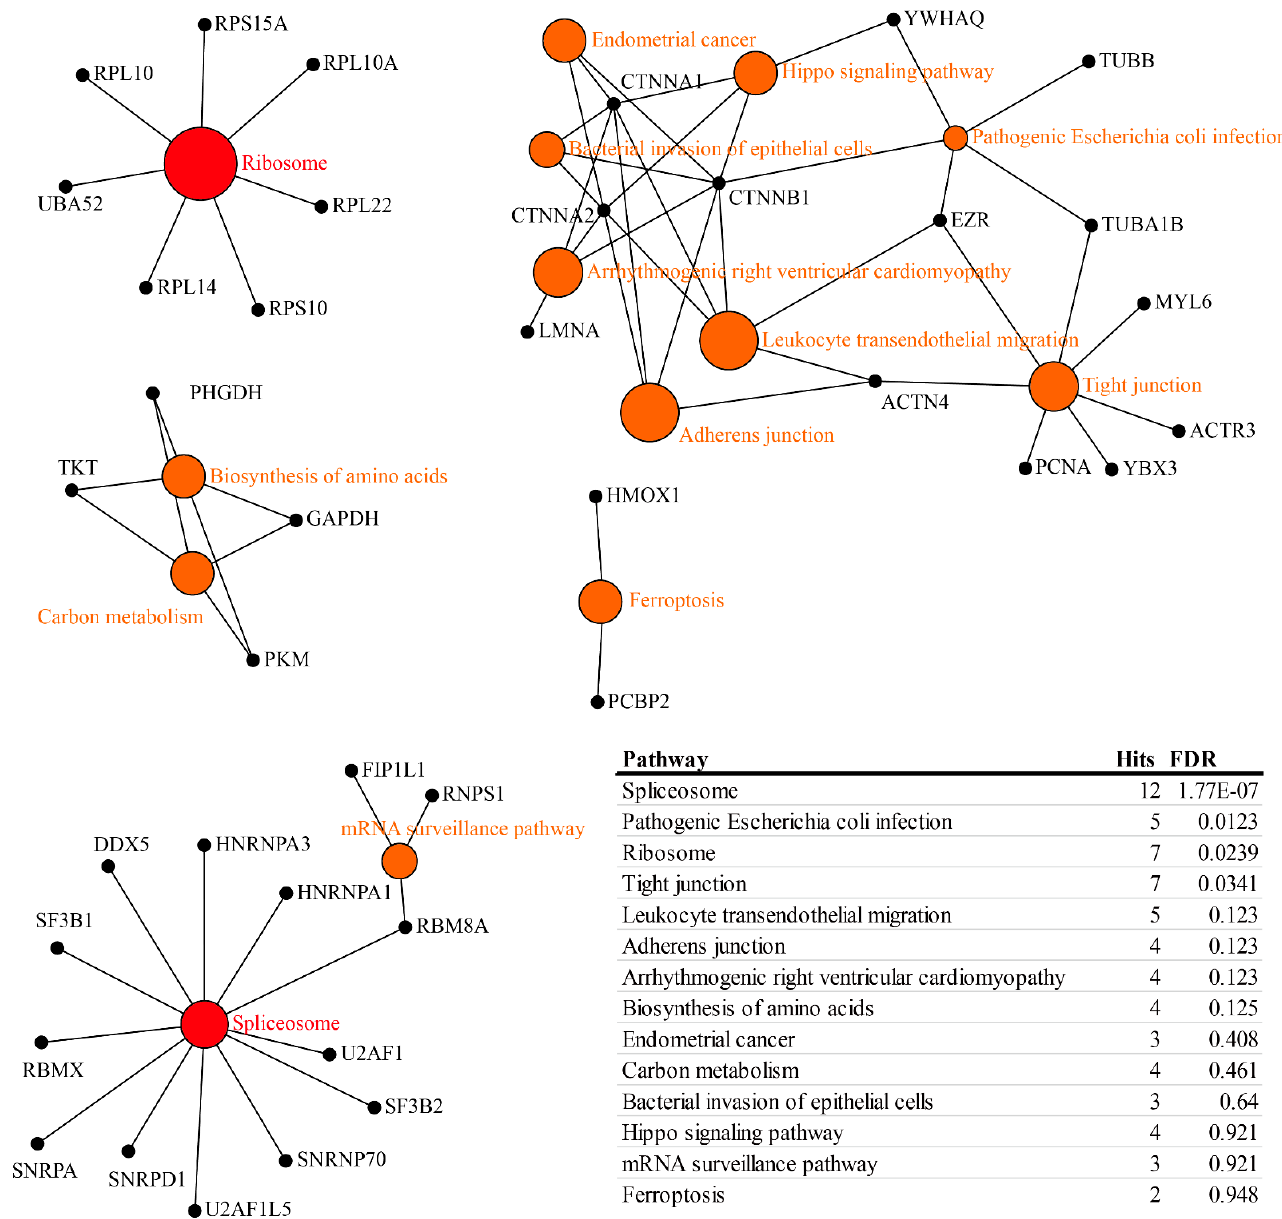
Figure 5. The enrichment network for differentially expressed proteins. Pathways were located in the center of networks, and the size of pathways were correlated with their enrichment